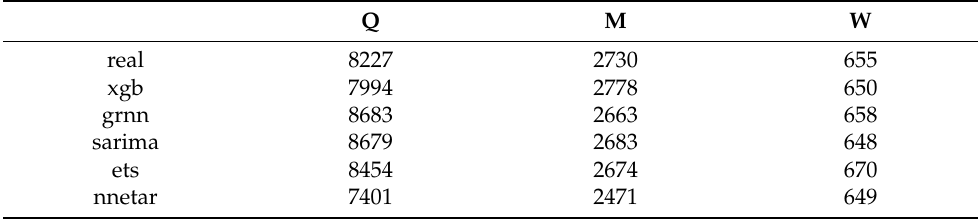
Table 6. 20% of the minimum demand for renewable energy (in GWh).